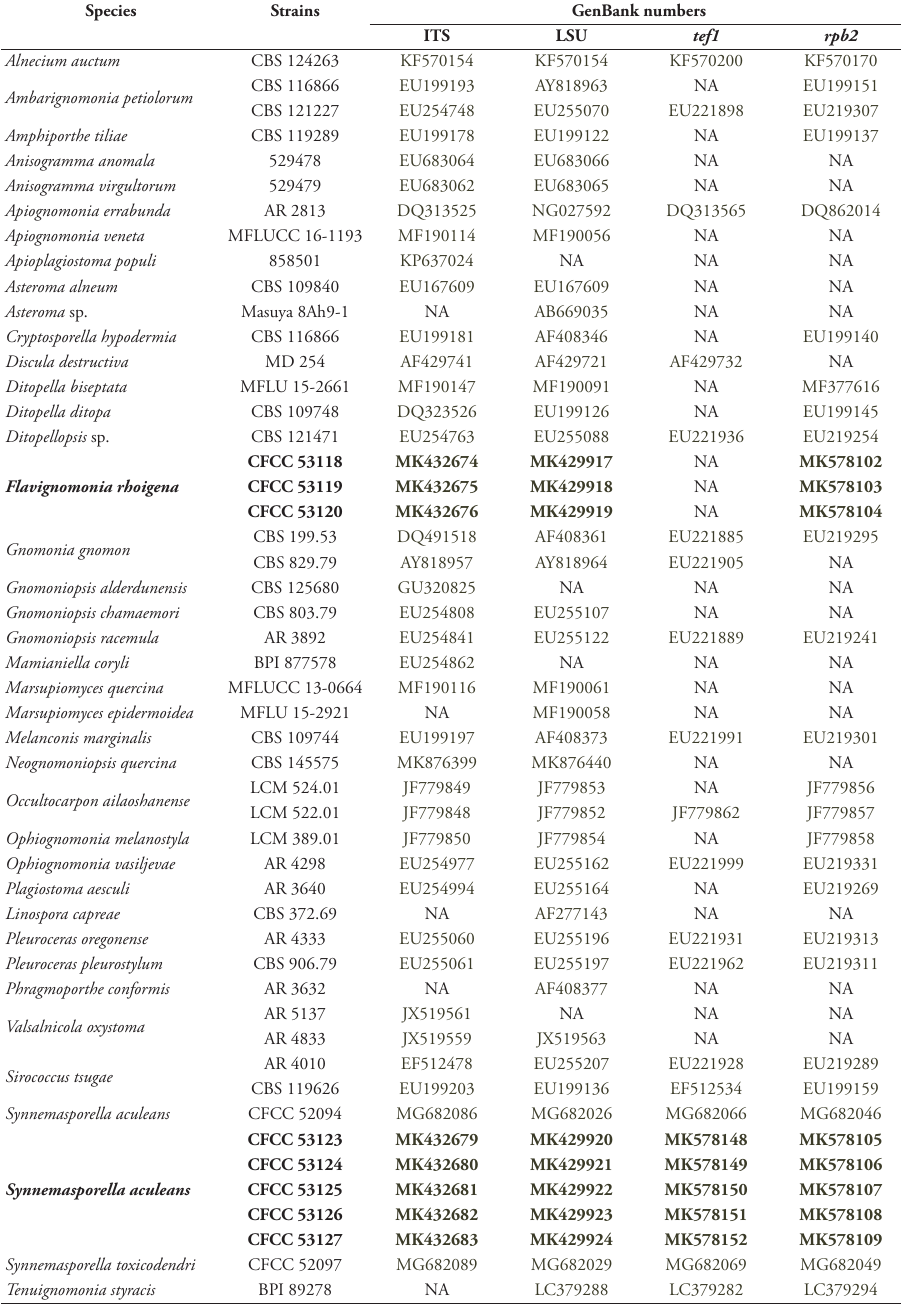
Table 1. Strains used in the phylogenetic tree and their culture accession and GenBank numbers. Strains from this study are in